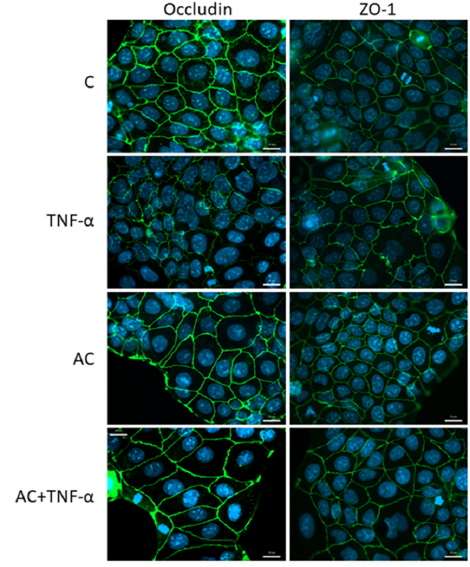
Figure 3. Effects of Anthocyanin (AC) and/or Tumor necrosis factor- α (TNF- α ) treatment on junctional morphology of Caco-2 cells. Cells were treated for 24 h with culture medium (C), 50 ng/mL TNF- α , 100 µM AC or in combination of 100 µM AC (pretreatment) and 50 ng/mL TNF- α (AC + TNF- α ). Immunostaining for Occludin and zonula occludens-1 (ZO-1) junctional proteins. Green color: immunostaining for Occludin, ZO-1. Blue color: staining of cell nuclei. Bar = 20 µm.